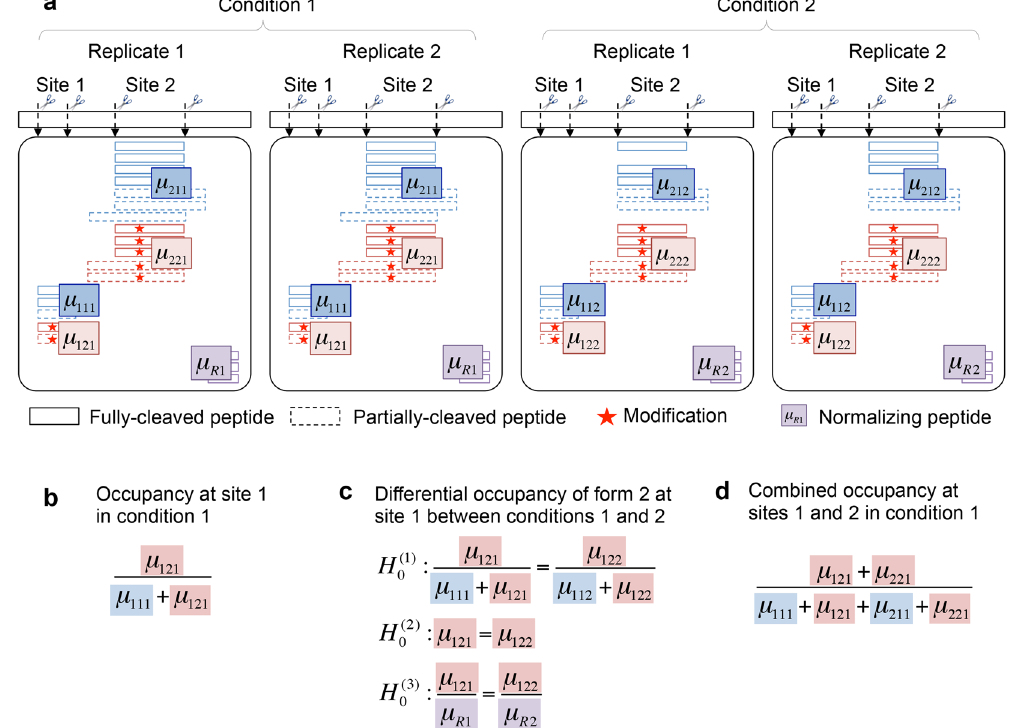
Figure 3. Goals of statistical characterization of therapeutic proteins. ( a ) Schematic representation of the data, in a simplified case of two conditions, two replicate runs, two sites and two forms. A form in each site is quantified by multiple spectral features (boxes), which are charge states and isotopes of a peptide. The feature intensities are viewed as repeated measurements of the underlying abundance of the form, where the abundance of site i , form j , and condition k is denoted by μ ijk . Peptides can be fully cleaved (solid lines) and/or partially cleaved (a.k.a., mis-cleaved, dashed lines). Some spectral features can be missing. ( b ) Goal 1: statistical characterization of site occupancy estimates the quantities underlying a peptide feature in each condition, replicate, site and form. ( c ) Goal 2: statistical characterization of differential site occupancy tests the null hypothesis of no change against the alternative. The hypotheses differ in the use of the normalizing factor in the denominator. ( d ) Goal 3: as in ( b ), but combining the quantitative information across multiple